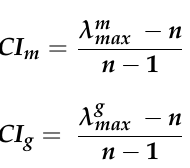
values of CR m and CR g are less than 0.1, the matrices are consistent.